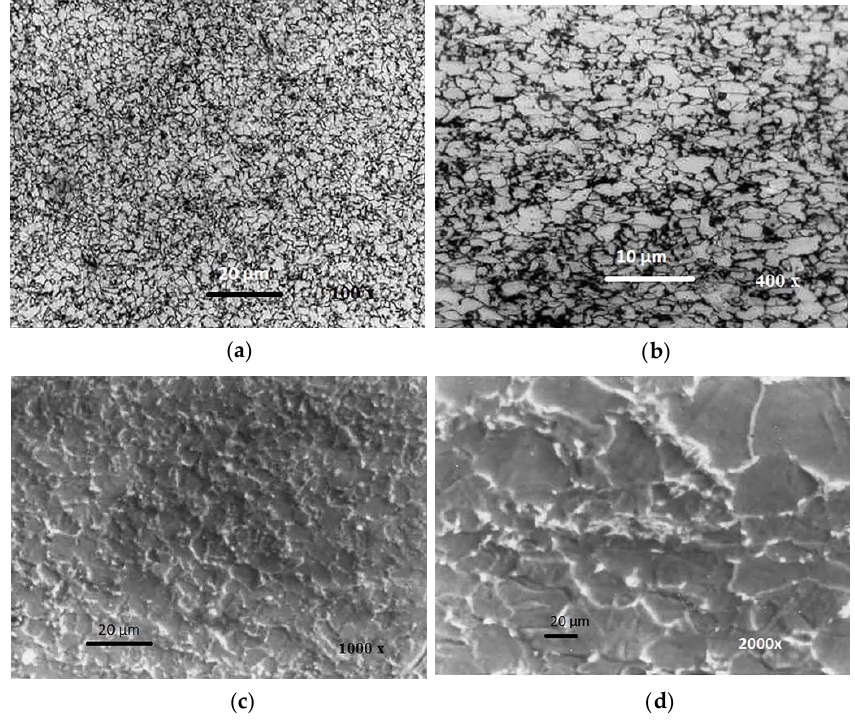
Figure 9. OM ( a , b ) and SEM ( c , d ) microstructure of the BM API 5CT J55.